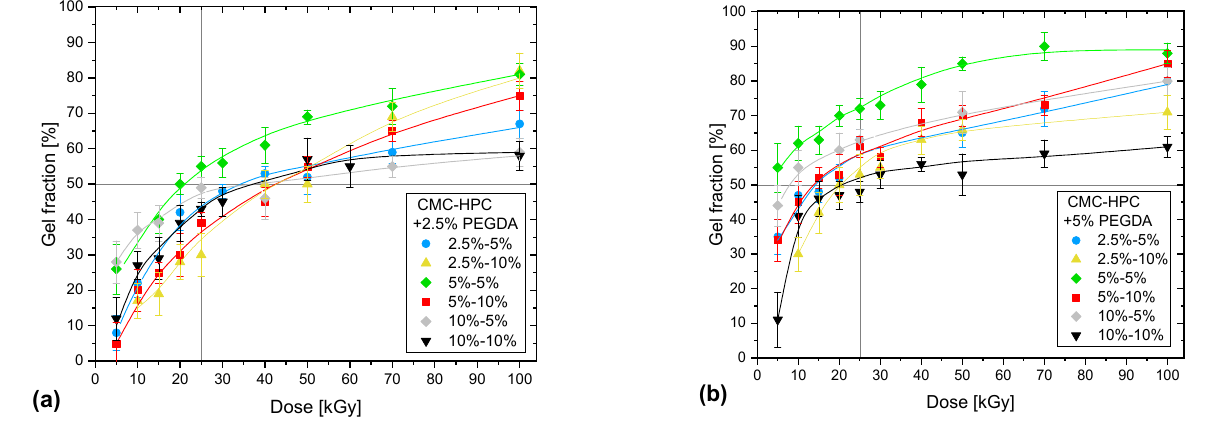
Figure 4. Gel fraction of hydrogels manufactured by irradiation of CMC-HPC-PEGDA in aqueous solutions, with a PEGDA concentration of ( a ) 2.5% and ( b ) 5%.